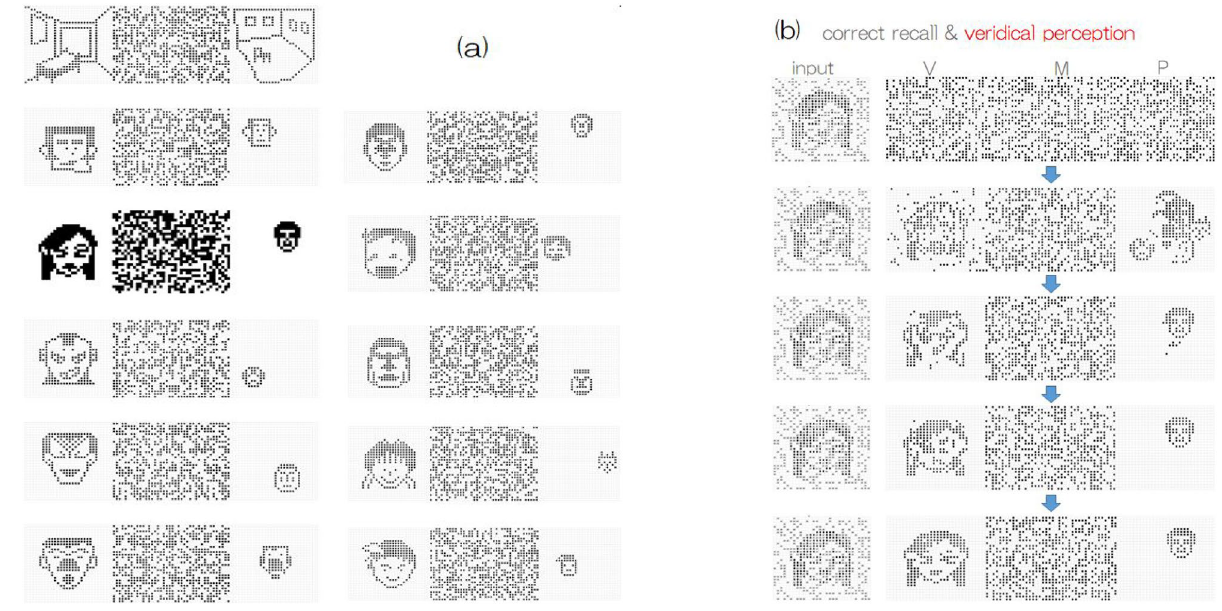
Figure 5. ( a ) Eleven perceiving attractors were used; where each attractor (limit cycle) contains 10 periodic bit- pattern sequences in each module. ( b ) An example of a converging update of neural activity from noisy inputs, which corresponds to veridical perception. Note that regardless of how noisy or deformed input deviating from the embedded 10 patterns is incorporated into the visual module, updating the activity gives the same fixed pattern in the perceiving module. This means that “ten to one correspondence mapping” was embedded in all perceiving attractors and is regarded as a metaphor of concept formation via veridical perceptions. In the Supplementary materials of this paper, readers are able to see animations of the time course in neural activity